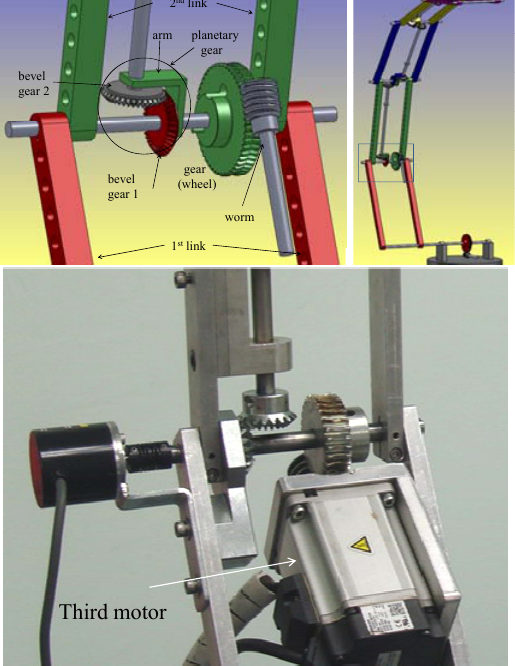
Figure 4. The design of the third joint angle (second link with third motor) of the manipulator [14]. The draft of the third joint angle using the SolidWorks software ( top left ). The draft of the whole manipulator using the SolidWorks software ( top right ). The mechanical design of the third joint angle ( bottom